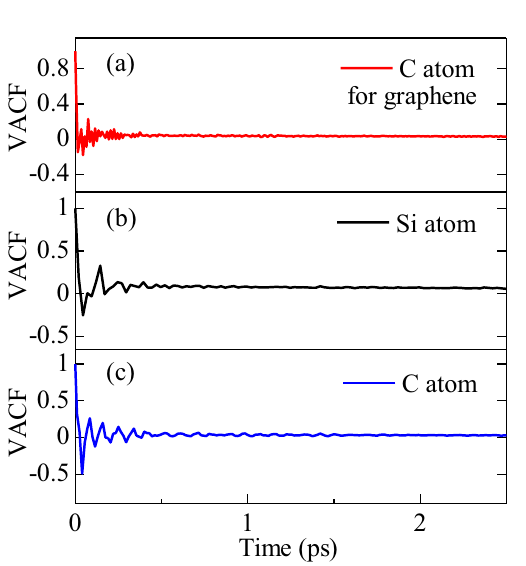
Figure 8. Calculated velocity auto correlation function (VACF) for ( a ) graphene, ( b ) Si, and ( c ) C demonstrating an eroding behavior for a correlation period of 1